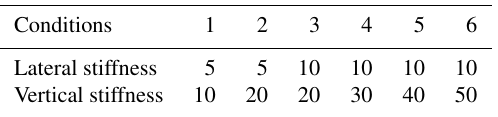
Table 3. Calculation conditions of fastener stiffnesses (unit: